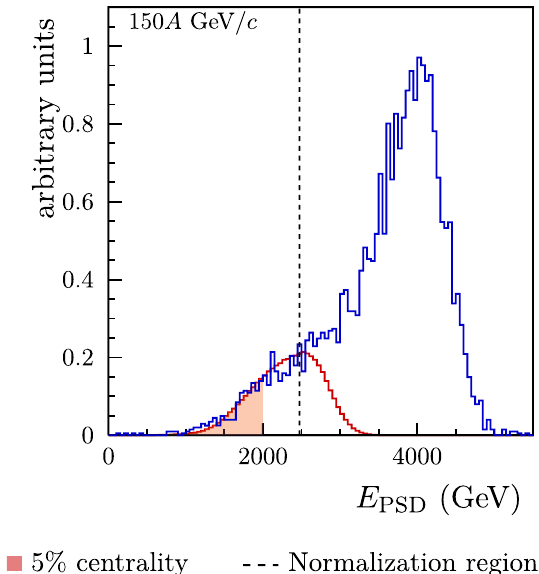
Fig. 3 Event centrality selection using the energy E PSD measured by the PSD calorimeter. Distributions are shown of measured E PSD for minimum-bias selected (blue histograms) and T2 selected (red his- tograms) events for 19 A (left plot) and 150 A GeV / c (right plot) beam momenta. Histograms are normalized to agree in the overlap region